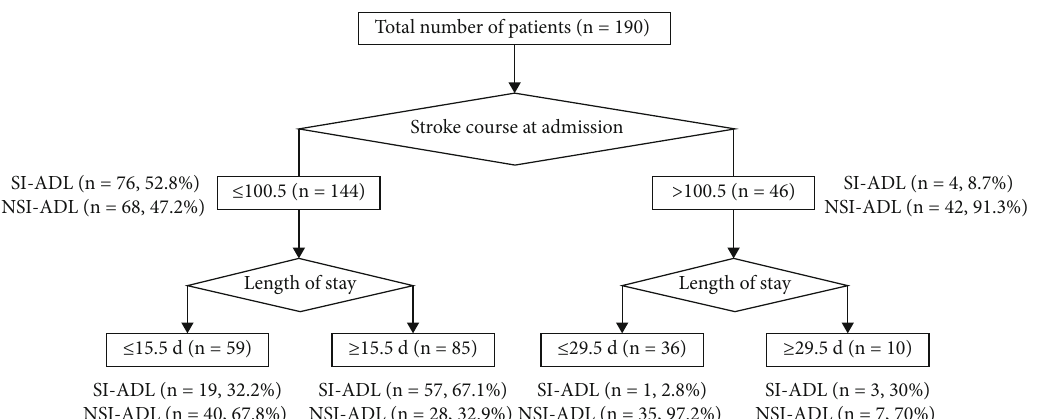
Figure 2: The SI-ADL decision tree model. The fi rst decision node indicates the course of the stroke at admission, followed by the length of hospital stay.